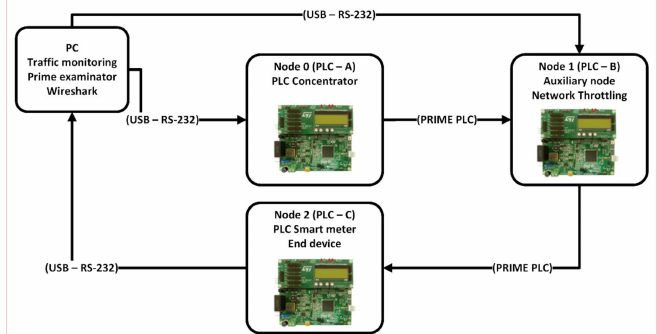
Figure 1. PoweRline Intelligent Metering Evolution (PRIME) data slicing test network topology.